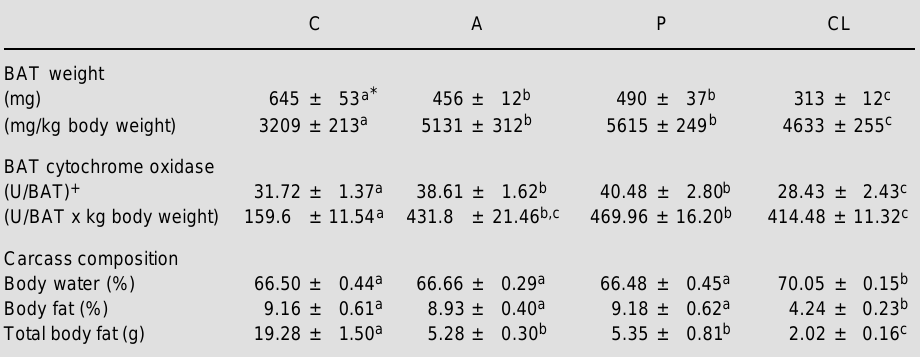
Table 4 - Effect of clenbuterol (CL) on brown adipose tissue (BAT) and carcass composition. Results are reported as means ± SEM for 6 animals per group. Group C: Normally fed control rats; group A: low-protein with free access to food; group P: pair-fed with group CL; group CL: low-protein diet + Cl for 2 weeks. Values on the same row not sharing a common superscript are significantly different (ANOVA followed by Fisher’s least-significant-difference test). + U (units) are defined as µmol of reduced cytochrome c oxidized/min per total interscapular brown adipose